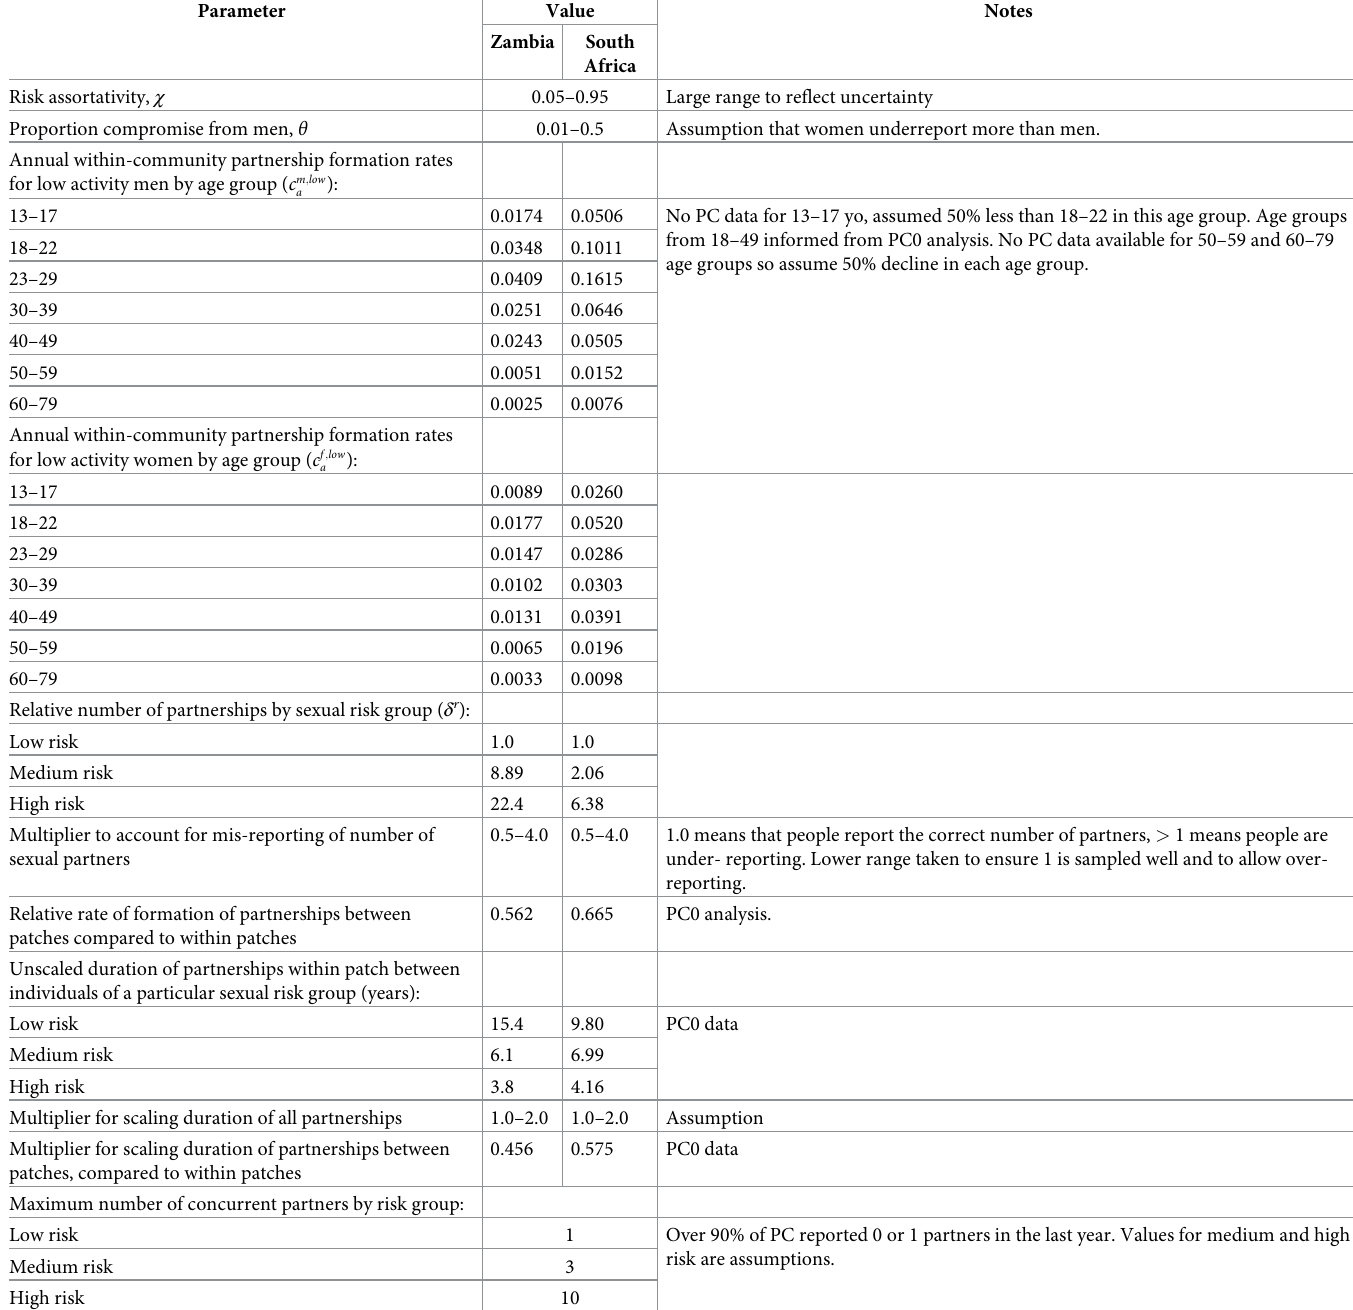
Table 1. Key partnership-related parameters used in